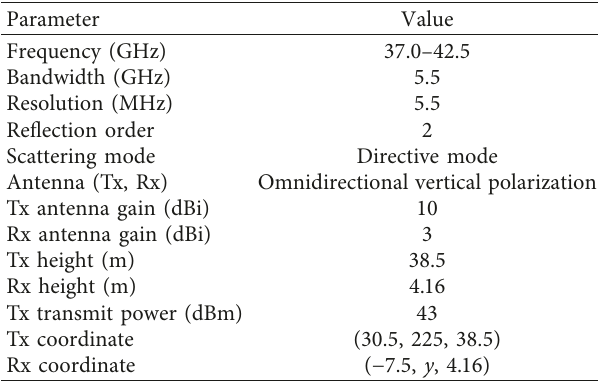
Table 3: Simulation